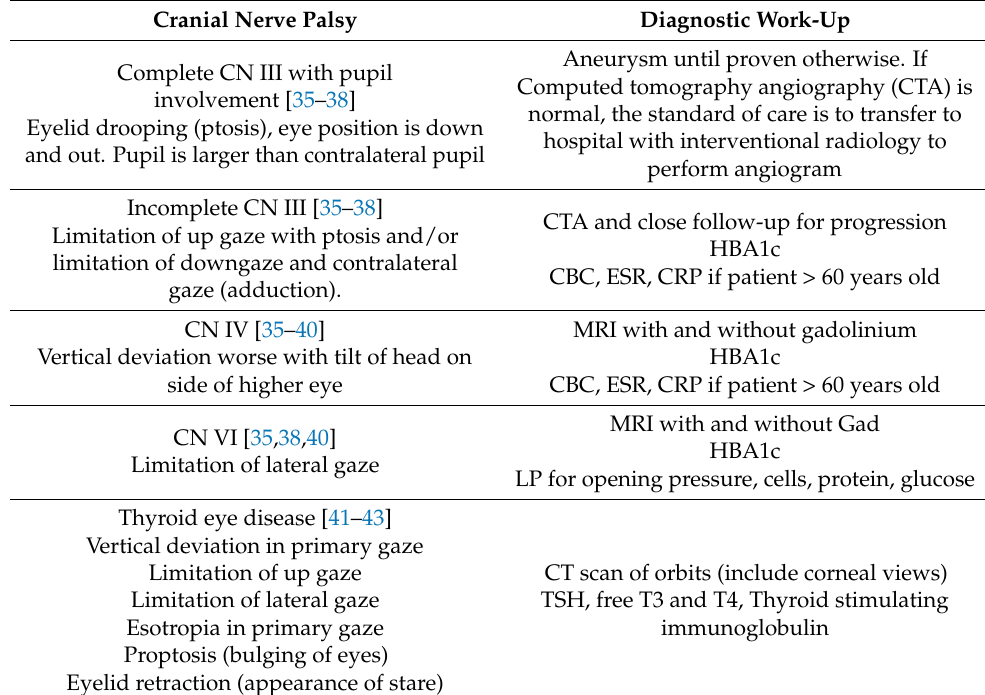
Table 7. Work up and management of binocular diplopia in the ED